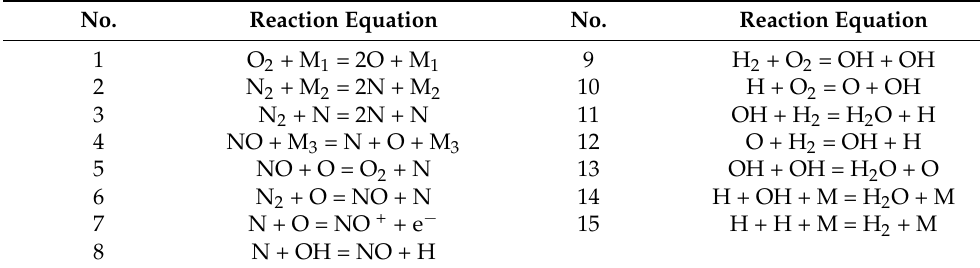
Table 4. Hybrid H 2 –air chemical reaction equations.